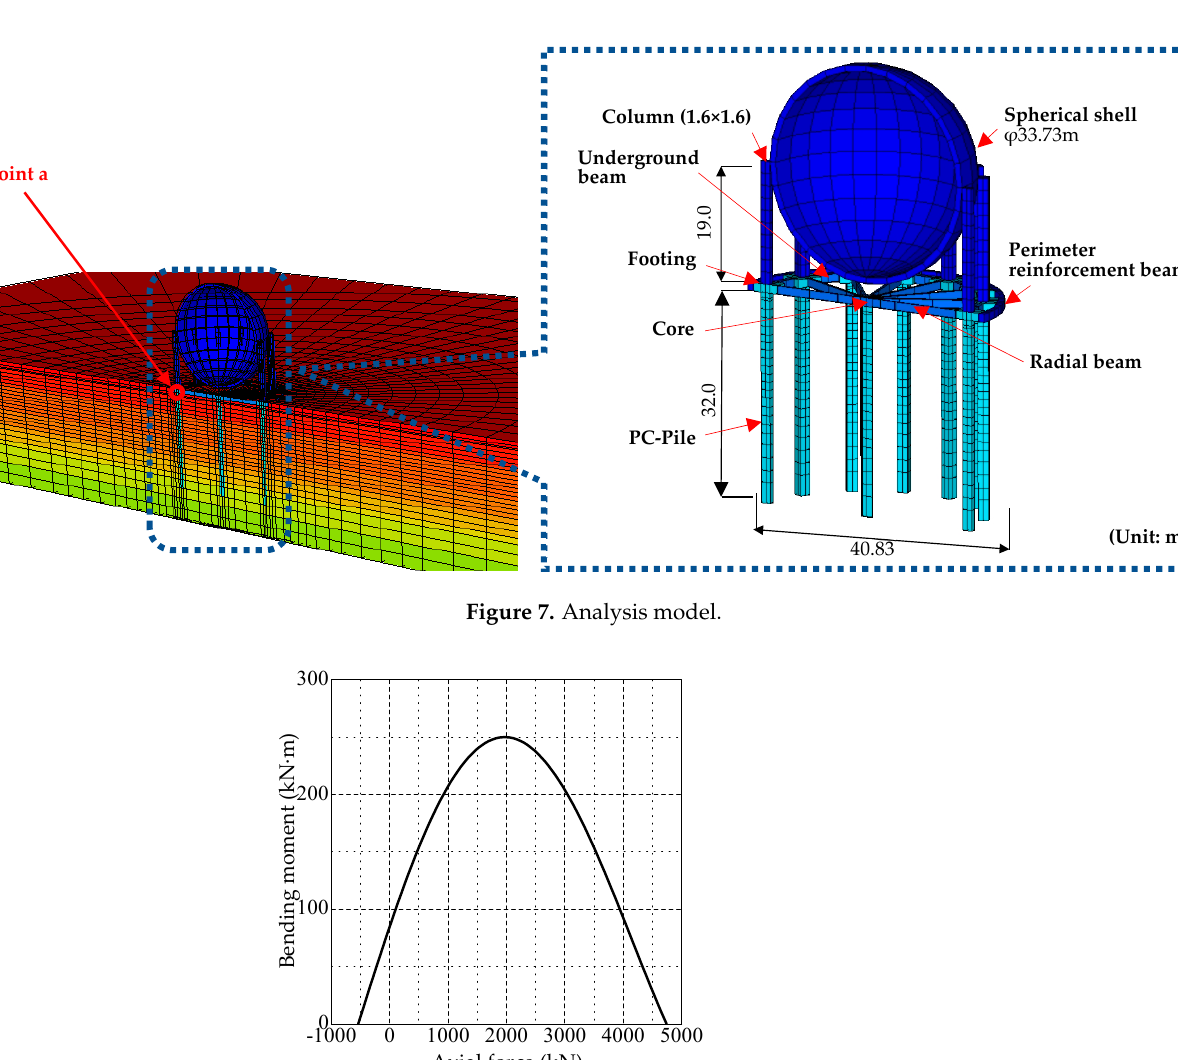
7 of 21 Figure 6. Spherical gas holder (analysis subject). Table 2. Holder specifications. Items